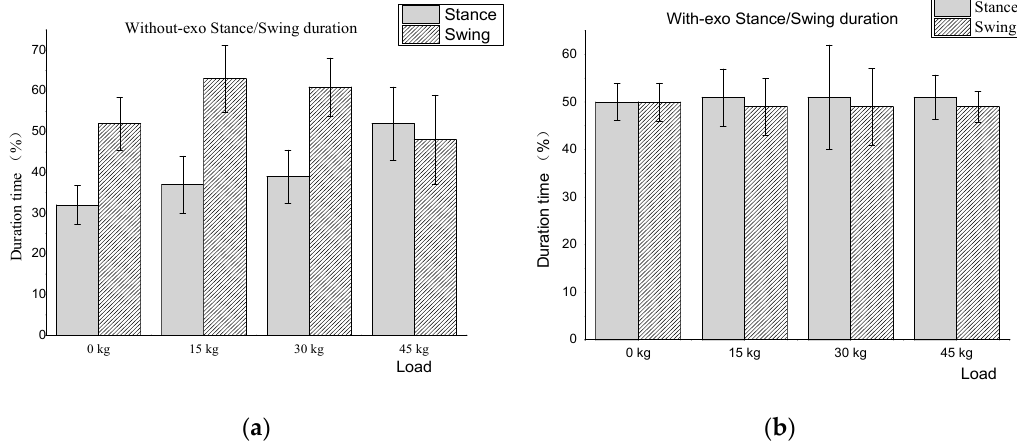
Figure 6. Comparison of gait phase stance and swing duration time. ( a ) without-Exo; ( b ) with-Exo.